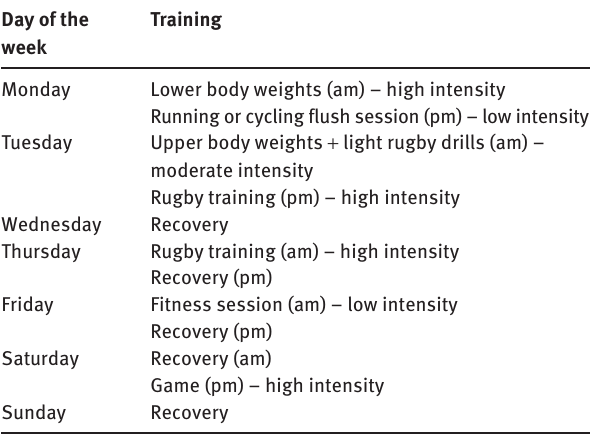
Table 1: Training and intensity for each regular season week throughout the professional rugby